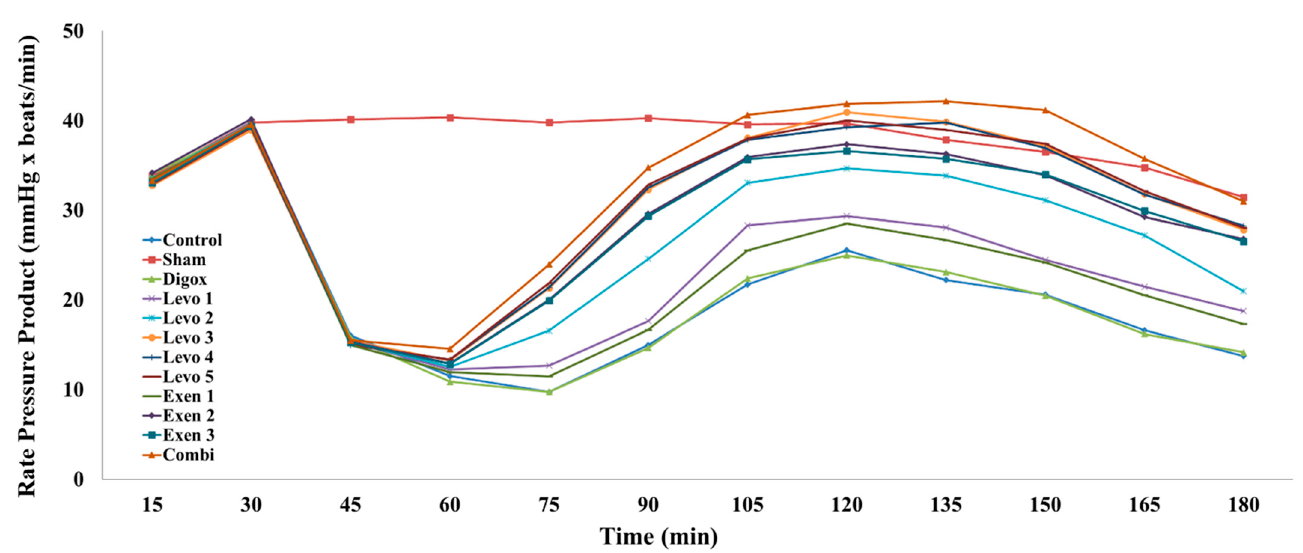
Figure 7. Changes in RPP across groups over